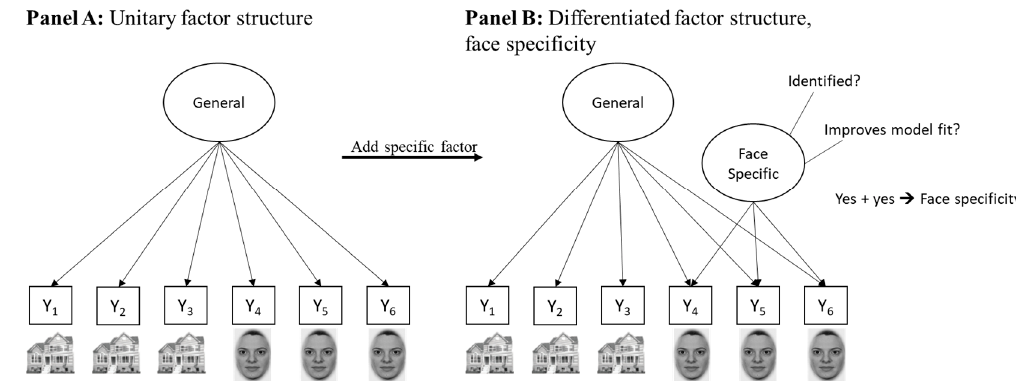
Figure 1. Schematic illustration of a model depicting a unitary factor structure ( Panel A ) and a factor structure differentiated for stimulus content ( Panel B ). The model in Panel B suggests face-specific abilities underlying the performance in tasks Y 1 –Y 6 . Y 1 –Y 6 —performance in six tasks or task trials with houses (Y 1 –Y 3 ) or faces (Y 4 –Y 6 ) as stimuli.